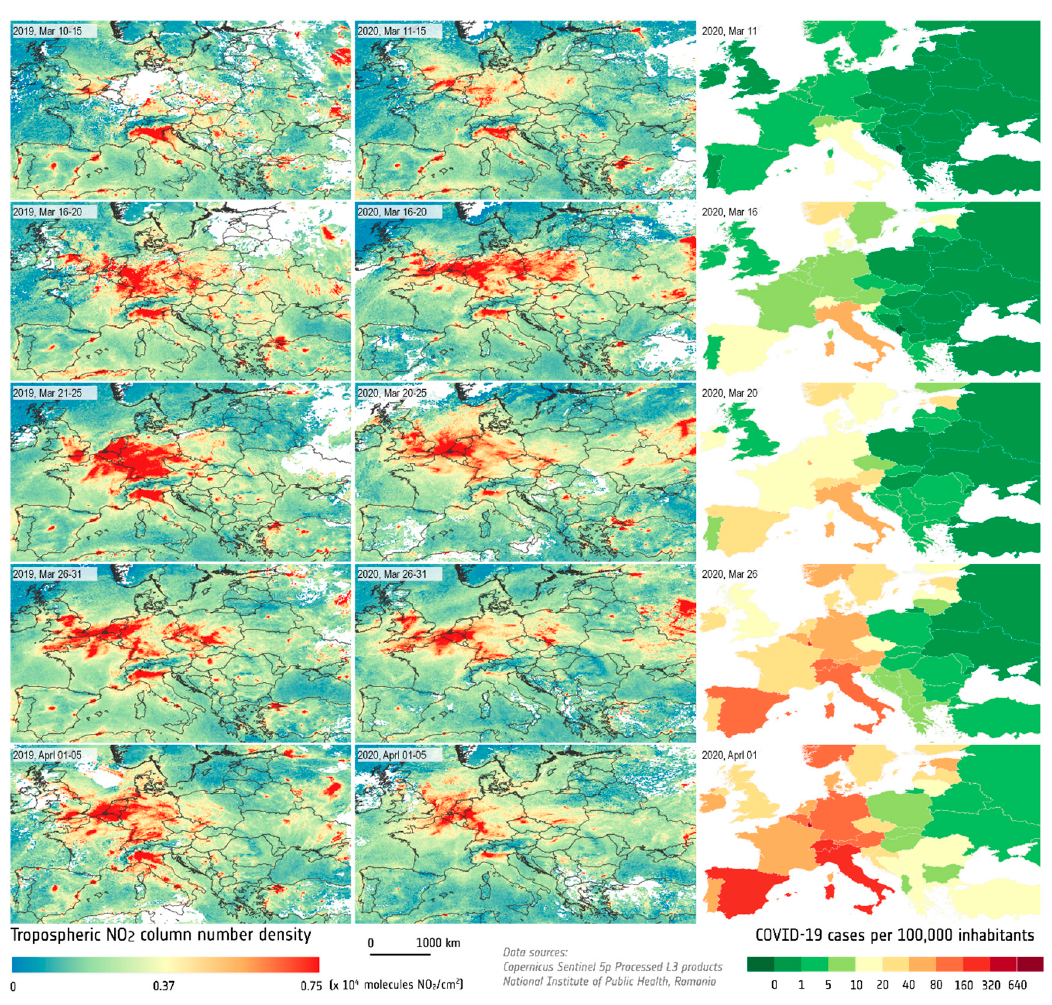
Figure 2. Comparative cartographic representations of the 5-day average tropospheric NO 2 column number density over Europe between 1 Marchto 5 April 2019 and 2020, and the incidence rate of COVID-19 confirmed cases in European countries.